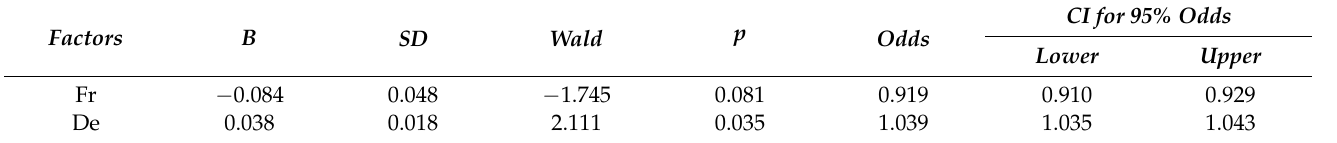
Table 5. Logit model for Depersonalization (DP) ˆL s ( Fr,De ) = ˆB 0 + ˆB Fr Fr + ˆB De De; s =